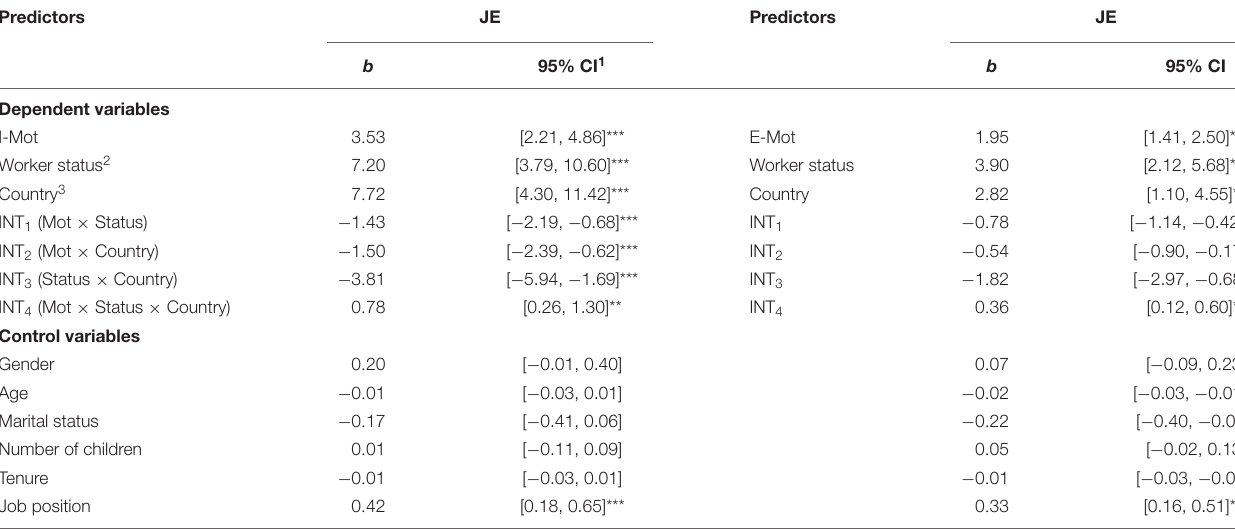
TABLE 6 | Moderated-moderation regression coefficients and confidence intervals (CIs) for predicting job engagement (JE). Predictors JE